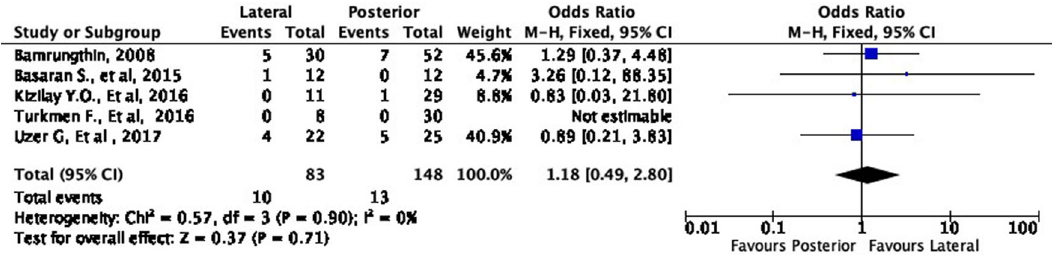
Figure 10. Comparison of functional outcome in the fair